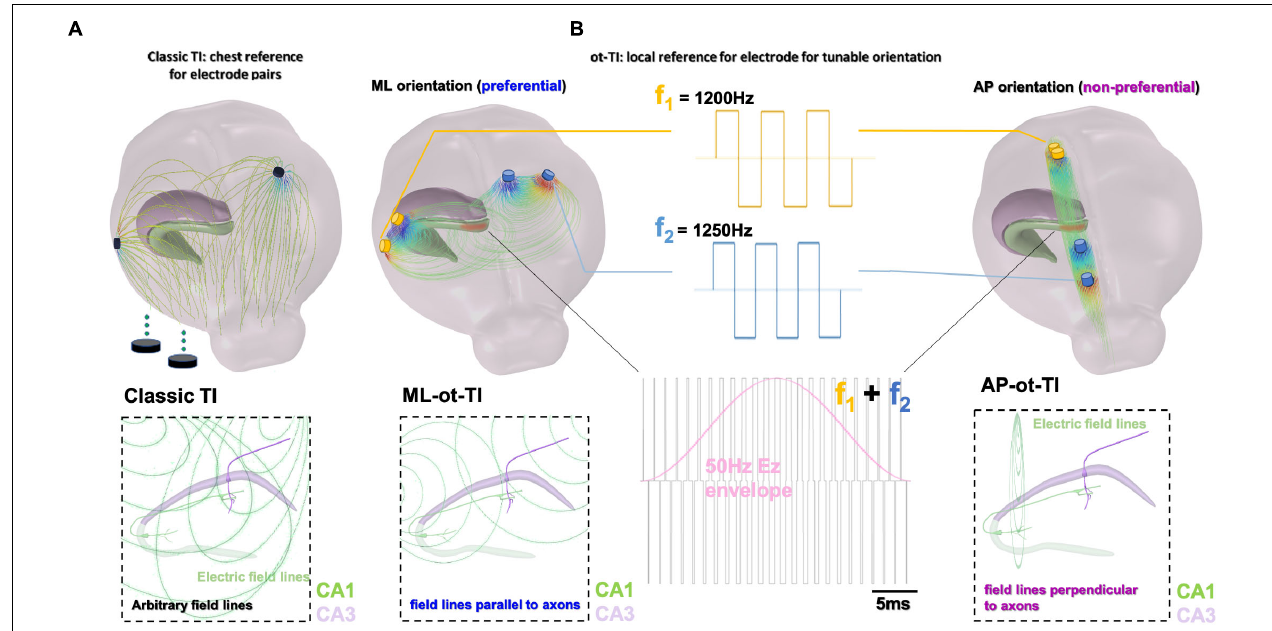
FIGURE 1 | Orientation-tunable Temporally Interfering Electric Fields (ot-TI). (A) Classic TI, using electrode pairs with references in the chest, a reliable method to non-invasively stimulate. However, field lines are arbitrary with respect to sub-cortical structures. (B) ot-TI, using electrode pairs with local references for controlled-orientation of electric field lines. Here, two perpendicular arrangements of ot-TI are shown, ML with field lines parallel to the alignment of axons in the hippocampus from CA3 to CA1, and AP with field lines perpendicular to the same axons. Classic TI stimulation is performed with sine waves, however, envelopes can also be created with other wave forms, for example square waves as seen here. These two configurations are compared experimentally to determine the minimally invasive efficacy of ot-TI to generate beta/gamma range oscillations and SLEs in the mouse